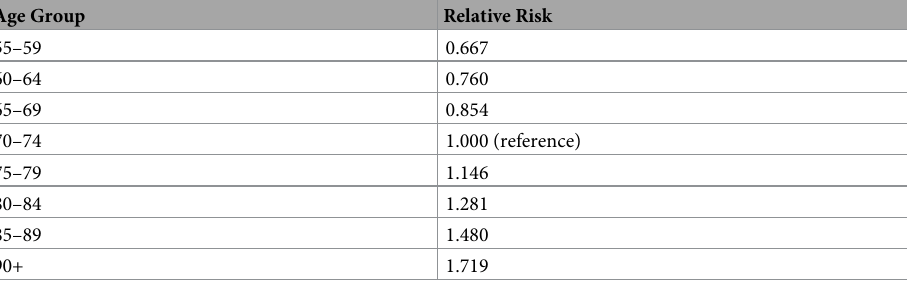
Table 2. Relative risk for ischaemic strokes by age group